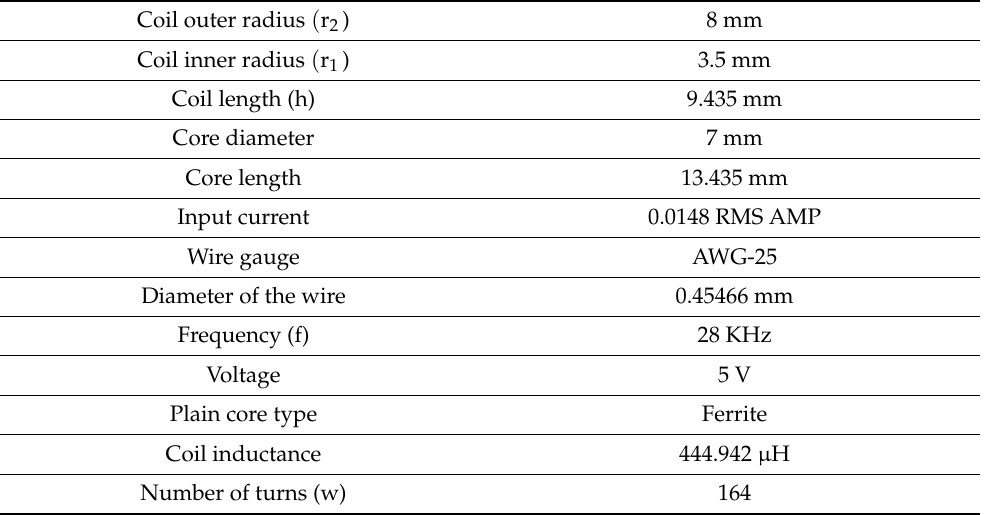
Table 1. Coil and Core Parameters of the Absolute